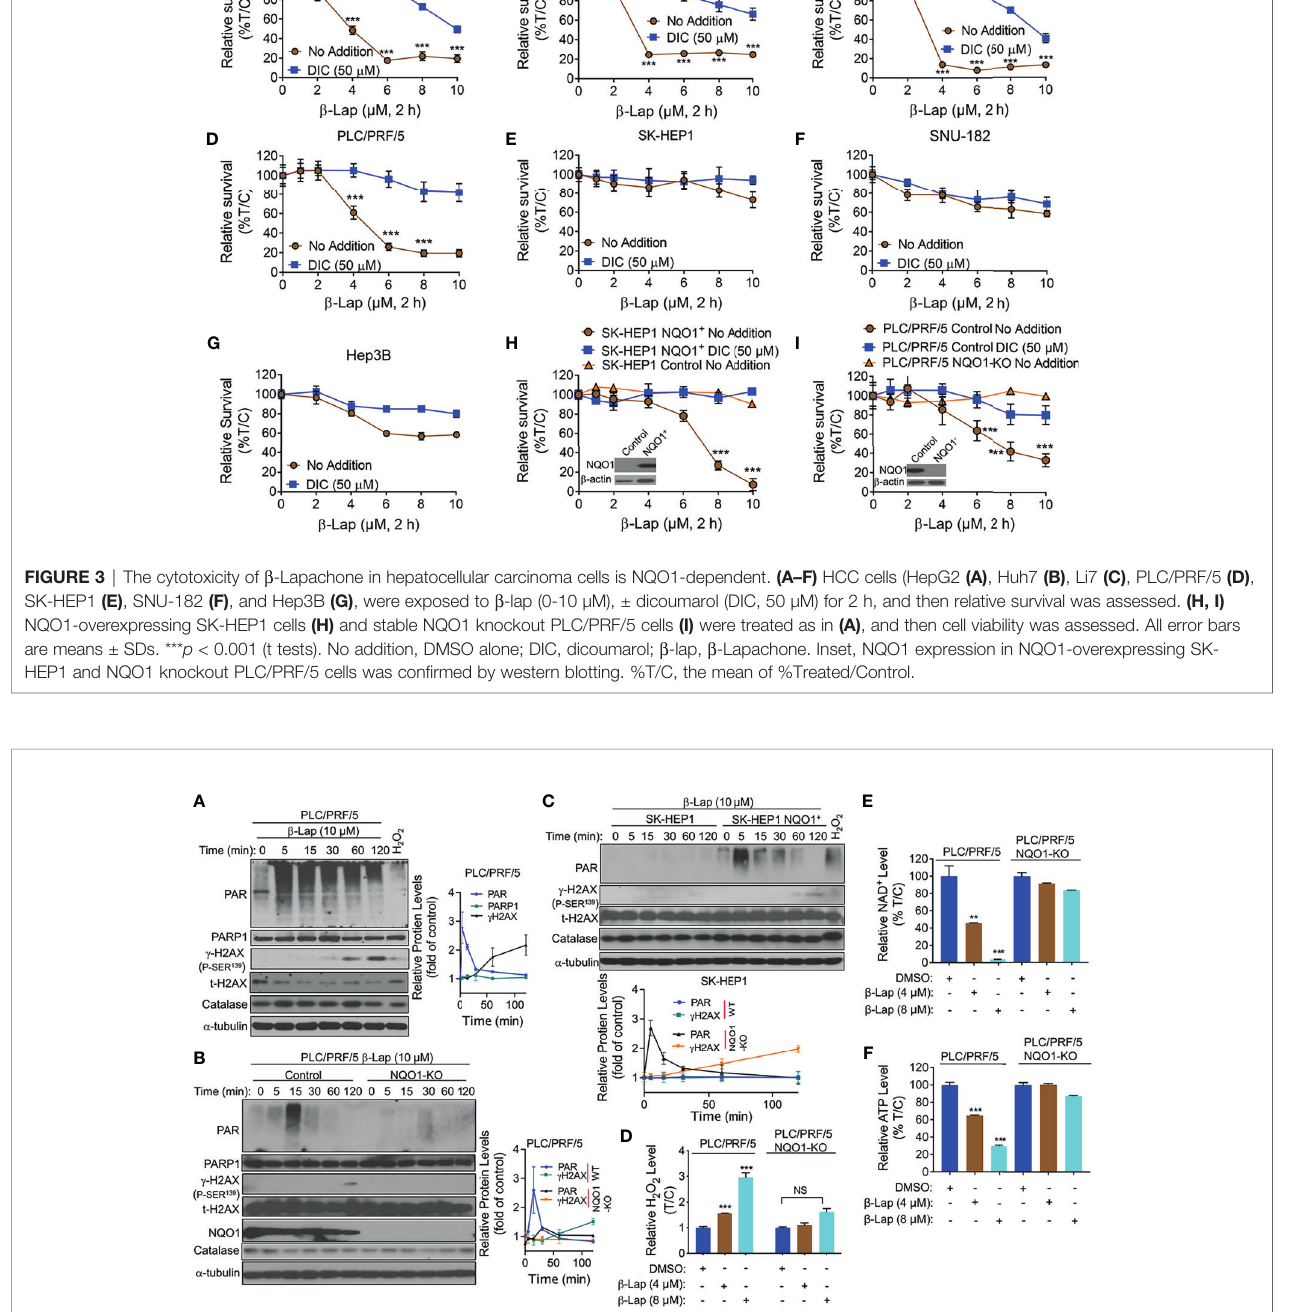
FIGURE 4 | b -Lapachone induces NQO1-dependent PARP1 hyperactivation, ROS formation and NAD + /ATP loss. (A – C) PLC/PRF/5 (A) , NQO1 knockout PLC/PRF/5, (B) and NQO1-overexpressing SK-HEP1, (SK-HEP1 NQO1 + ) (C) cells were exposed to 10 µM b -lap for the indicated times. Cells were then harvested, and western blotting analysis was performed to detect the levels of PAR (PARP1 hyperactivation), PARP1, NQO1, catalase and g H2AX. The protein levels of PAR and g H2AX were quanti fi ed by Image J and normalized to a -tubulin, which was used as a loading control. (D – F) PLC/PRF/5 cells were treated with or without b -lap (4 or 8 µM) ± DIC (50 µM) for 2 h. Then, cells were subjected to measurement of H 2 O 2 levels (D) , NAD + levels (E) and ATP levels (F) . Data represent at least three independent sets of experiments. Error bars are means ± SDs. *** p < 0.001, ** p < 0.01 (t tests). T/C, the mean of Treated/Control in (D) %T/C: the mean of %Treated/Control in (E, F) . NS, Not Statistically Signi fi cant